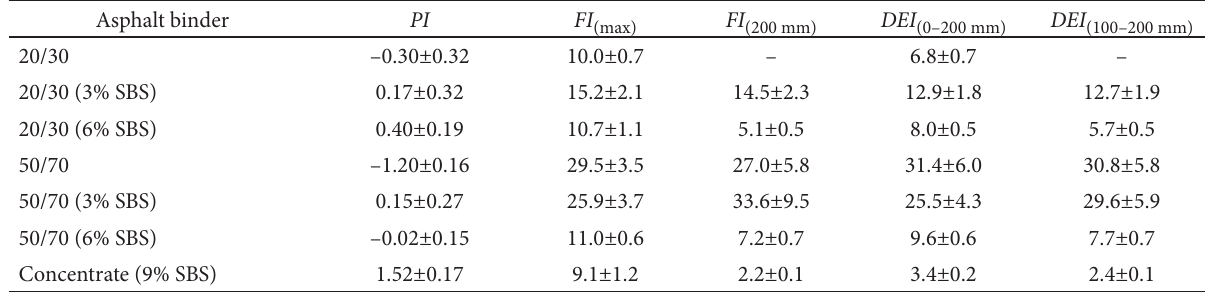
Table 8. The values of coefficients characterizing the temperature susceptibility of the tested asphalt binders Asphalt binder